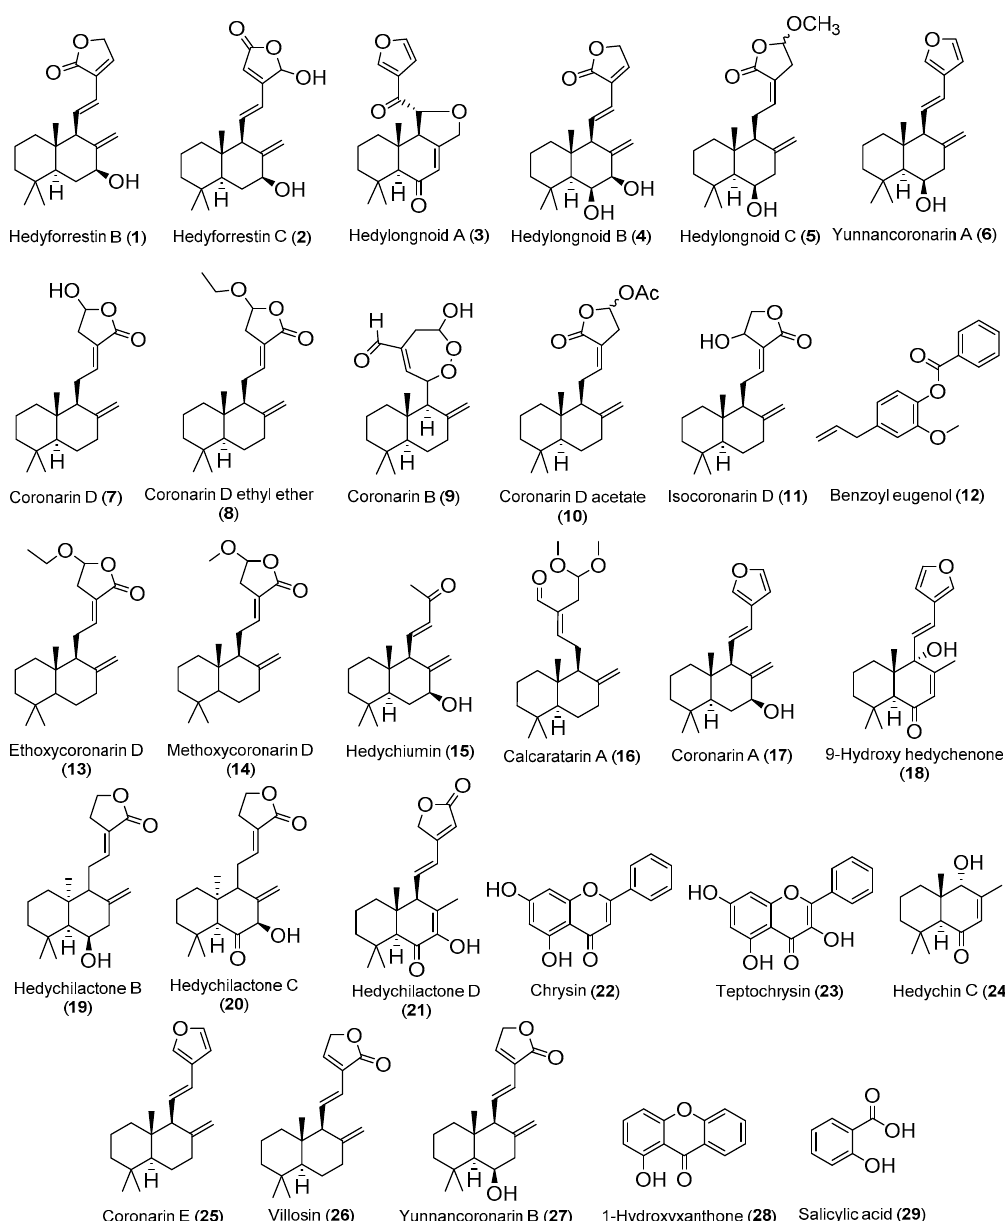
Figure 1. Chemical structure of the compounds referred on Table 2.